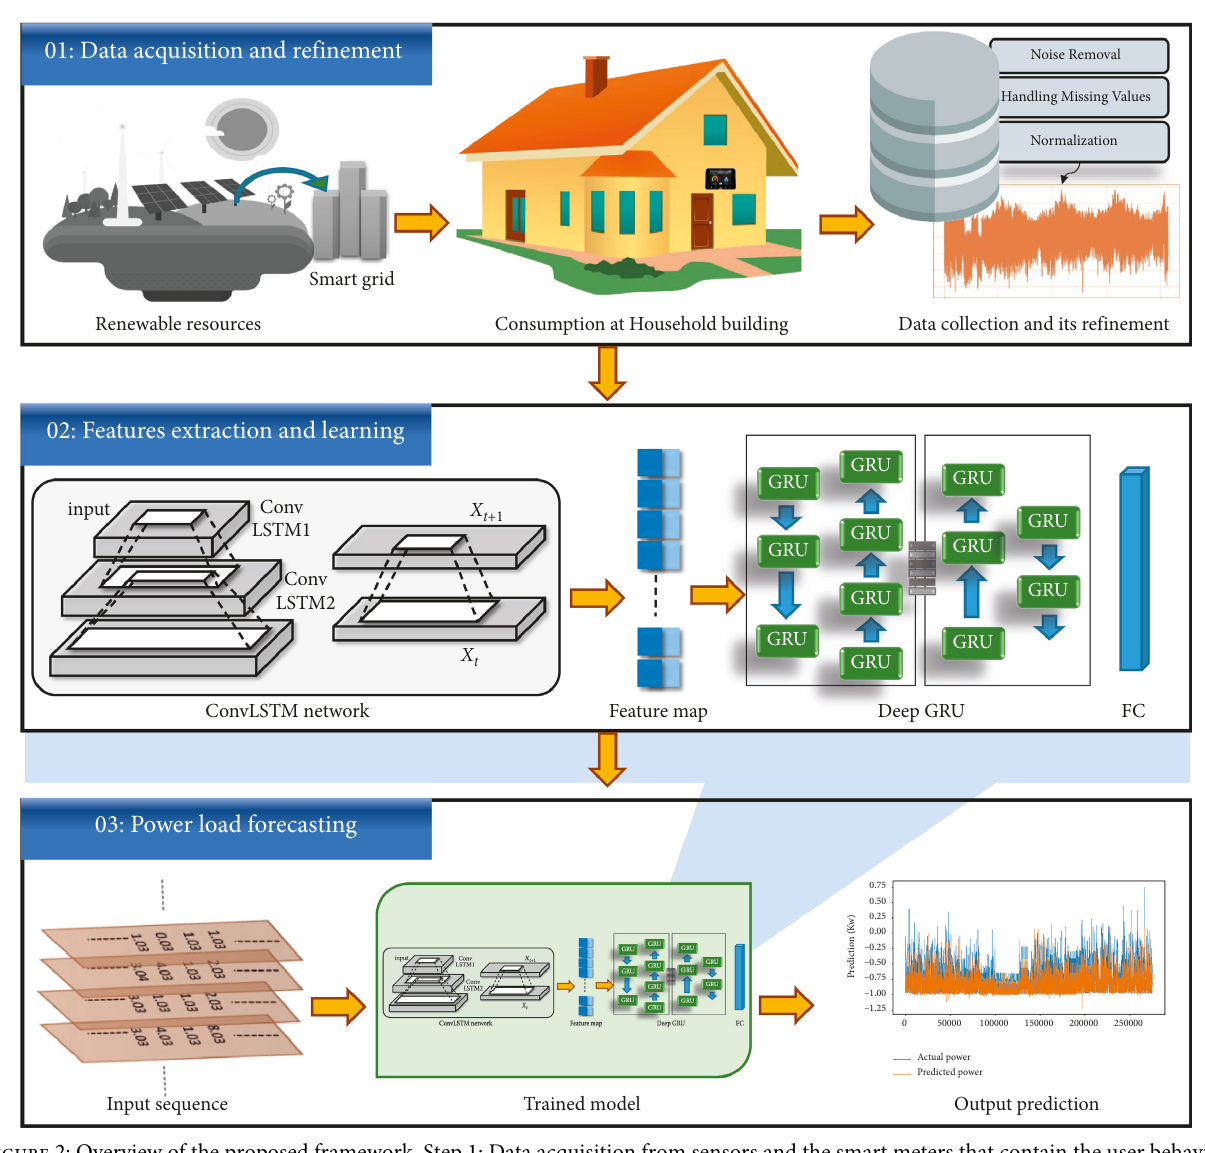
Figure 2: Overview of the proposed framework. Step 1: Data acquisition from sensors and the smart meters that contain the user behavior for data management and response to energy usage. Also, its refinement is performed to stabilize and remove the user behavior. Step 2: Detailed feature extraction from the energy data through ConvLSTM. Step 3: The prediction of future energy consumption based on the input data